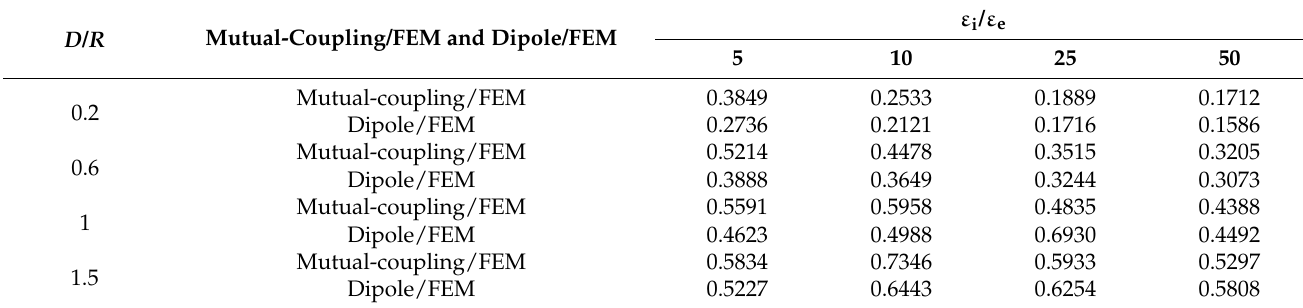
Table 3. The similarity of the curves under a transverse external electric field (mutual-coupling/FEM and